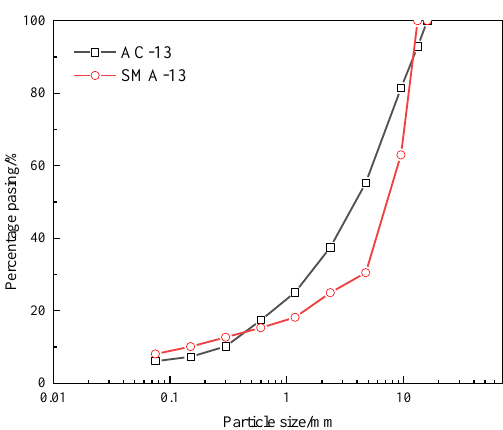
Figure 1. Gradation of the mixtures.